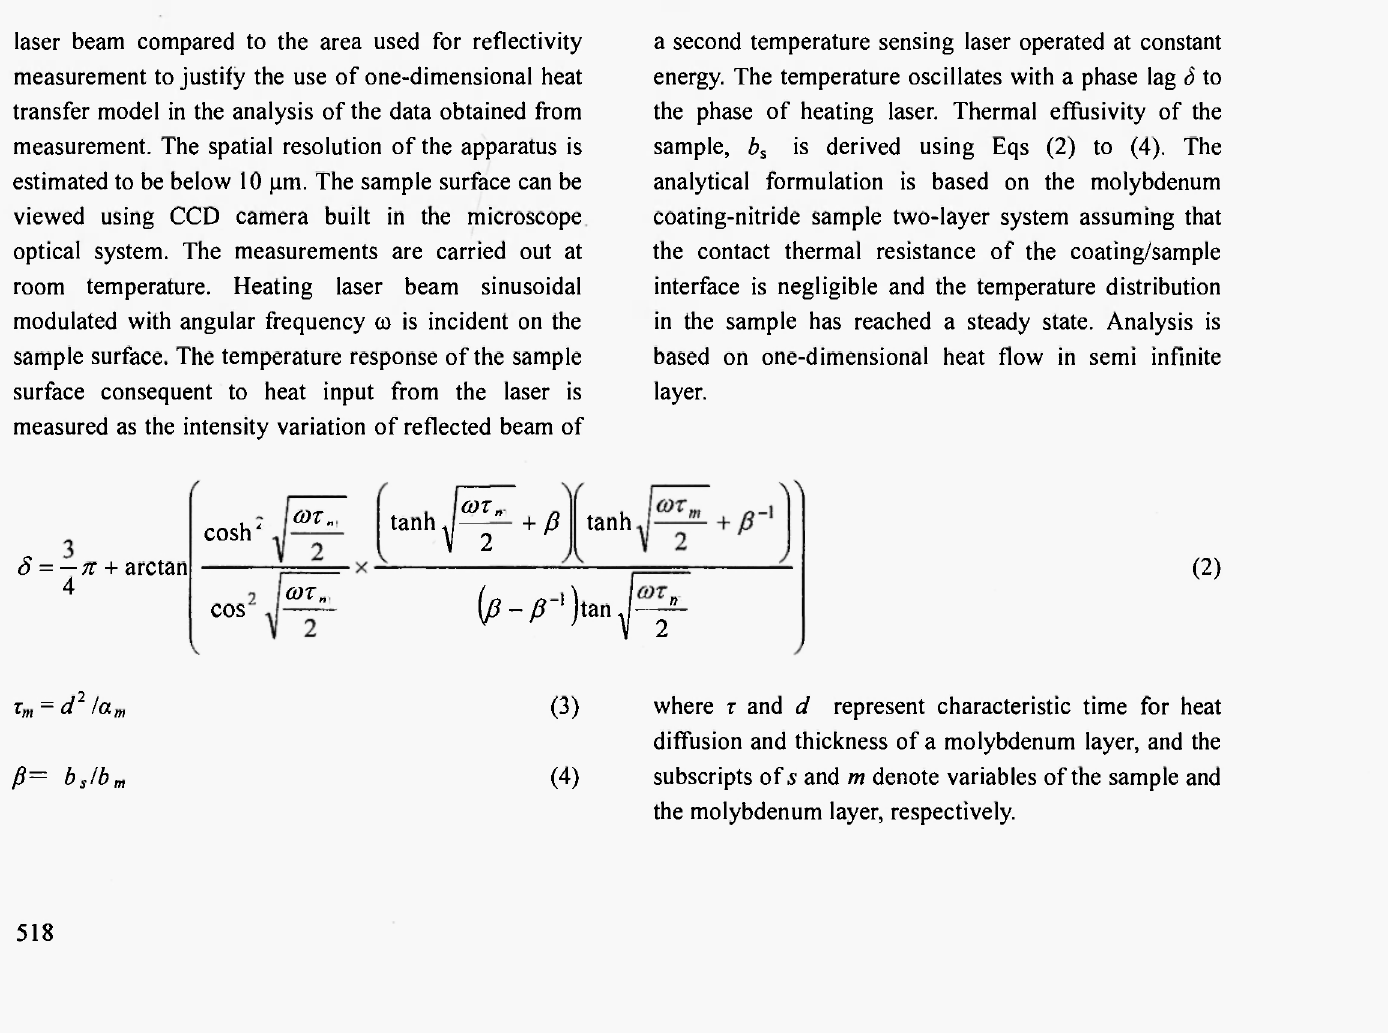
Fig. 2: Schematic diagram of the thermal microscope used in this